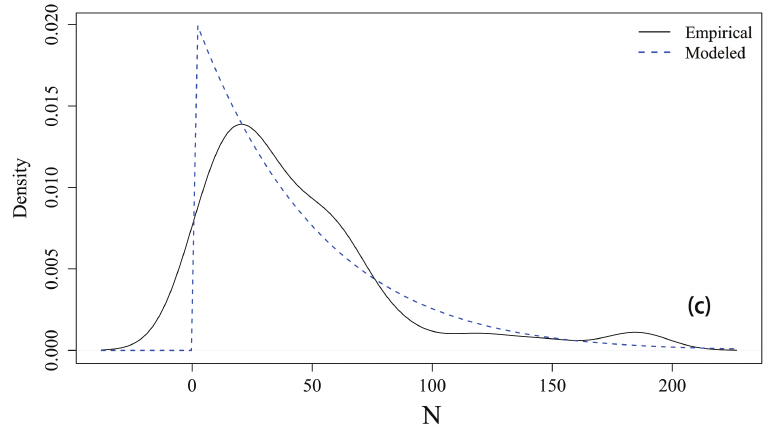
Figure 9. Three diagnostic plots fitting the GEV to the maximum values at a daily scale. ( a ) The QQ-plot compares the empirical data quantiles and the GP fit quantiles. ( b ) The QQ-plot shows the randomly generated data, which is from the fitted GP, against the empirical data quantiles, and the 95% confidence bands (black dashed line) of the QQ-plot get close to be linear. ( c ) The plot shows that the empirical density of the observed maximum (black solid line) against GEV fit density (blue dashed line).